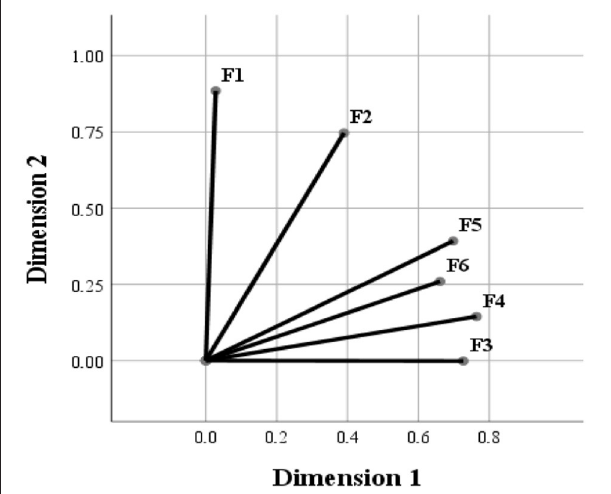
FIGURE 5 | Purchasing factors analyzed by CATPCA. Source: Results of the questionnaire survey, output of the SPSS version 25. F1- price level, F2-